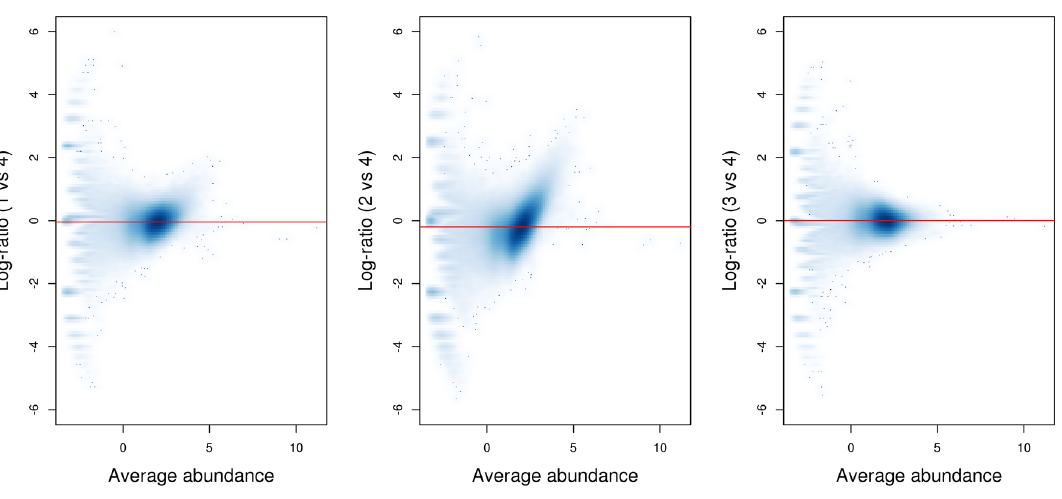
Figure 11. Mean-difference plots for the bin counts, comparing library 4 to all other libraries. The red line represents the log-ratio of the normalization factors between